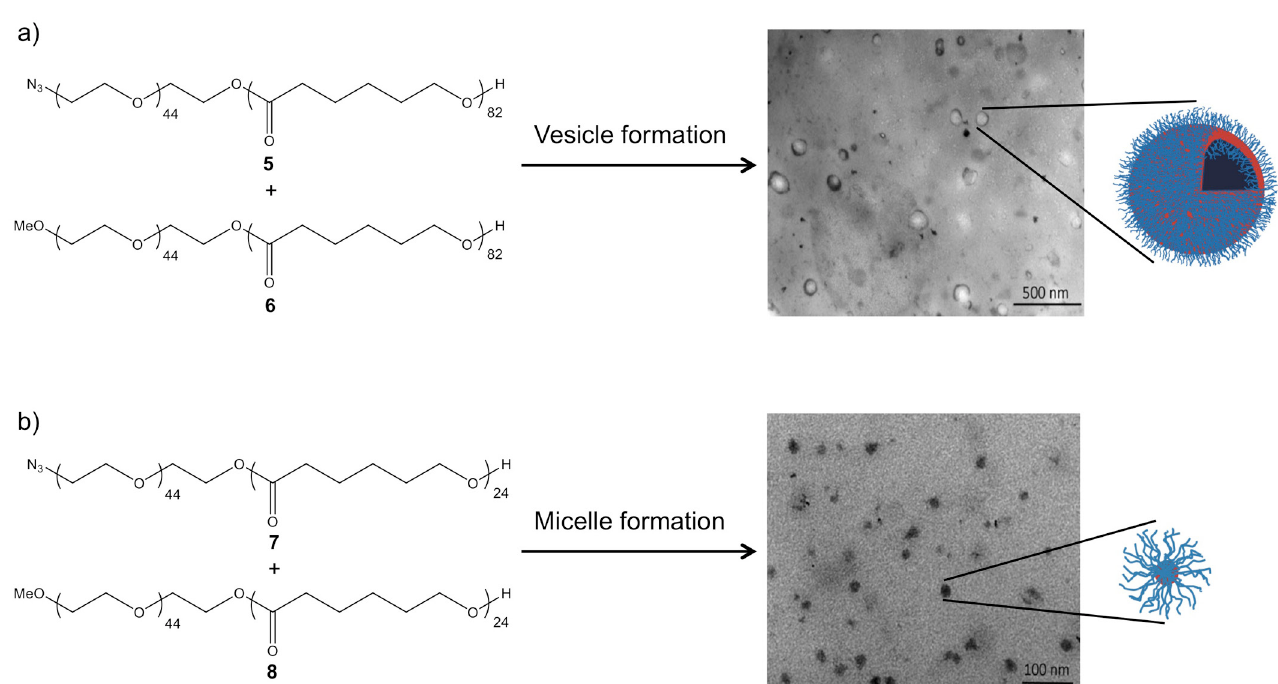
FIGURE 10 - Assembly of PCL-PEO diblock copolymers into a) vesicles; b)